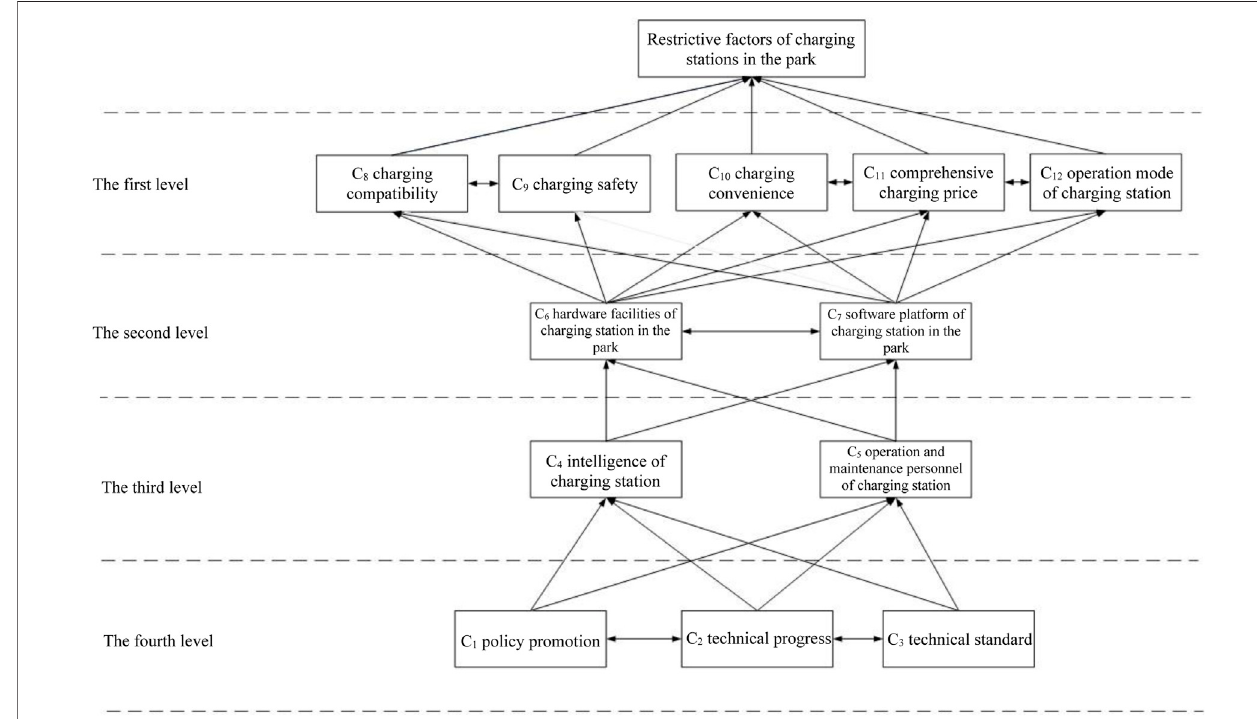
FIGURE 1 | ISM of restrictive factors for EV charging piles in the